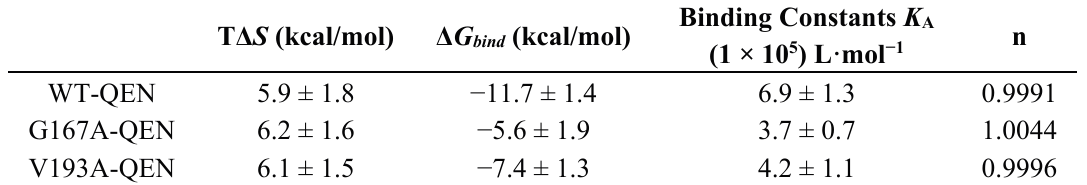
Table 2. The calculated energy components, binding free energy (kcal/mol), binding constants and number of binding sites of the WT-QEN, G167A-QEN and V193A-QEN systems based on the fluorescence spectroscopy quenching